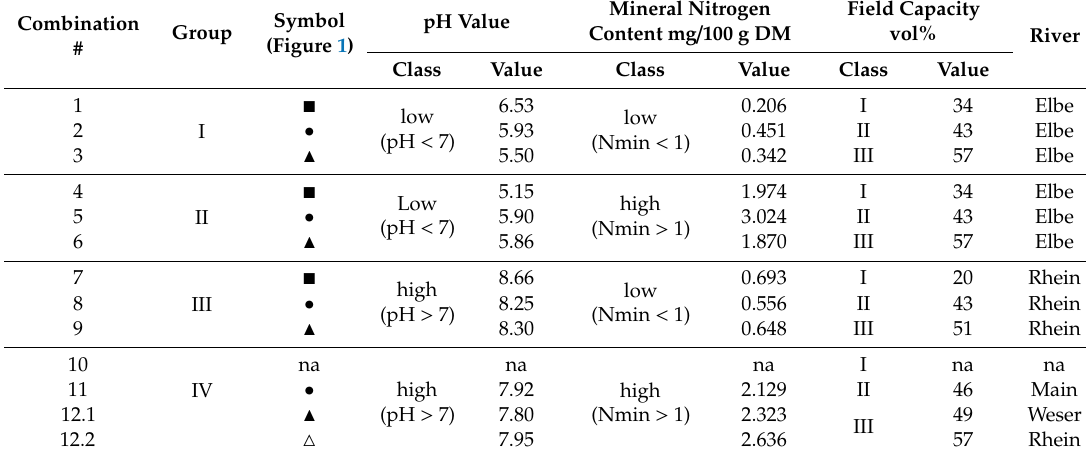
Table 1. Selection of soil sample subset based on the combination of the defined classes and on the parameters: pH, mineral nitrogen (Nmin), field capacity (FC) (pH value into 2 classes: low (pH < 7) and high (pH > 7); Nmin into 2 classes: low (Nmin < 1mg / 100g DM) and high (Nmin > 1mg / 100g DM); FC into 3 classes: class I—very low / low / medium (FC = 21 vol% < FC ≤ 39 vol%), class